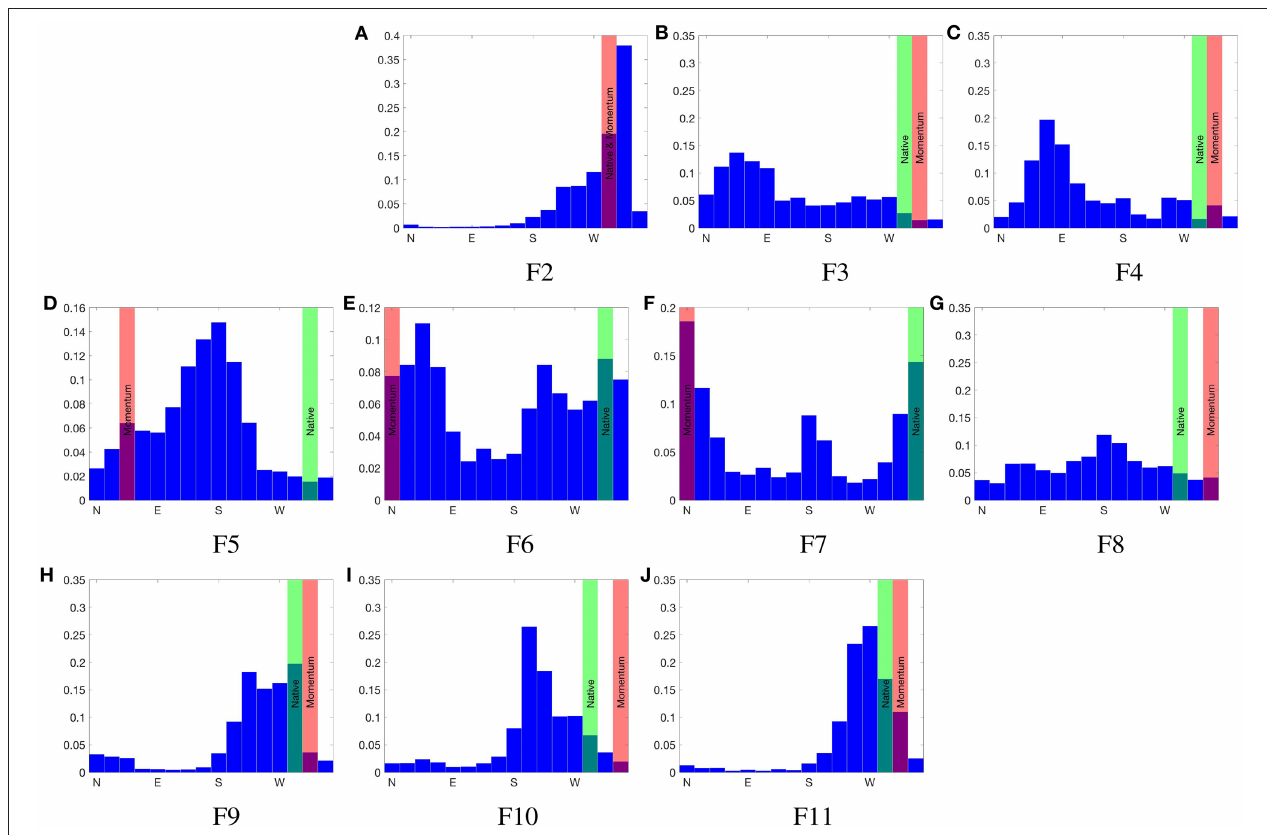
FIGURE 7 | Observed wind direction distribution at sites (A–K) F1 to F11, across Flea Creek Valley, conditional on a WNW wind observed at F1. Predicted wind directions using WindNinja with native solver are indicated in green, and with momentum solver are indicated in